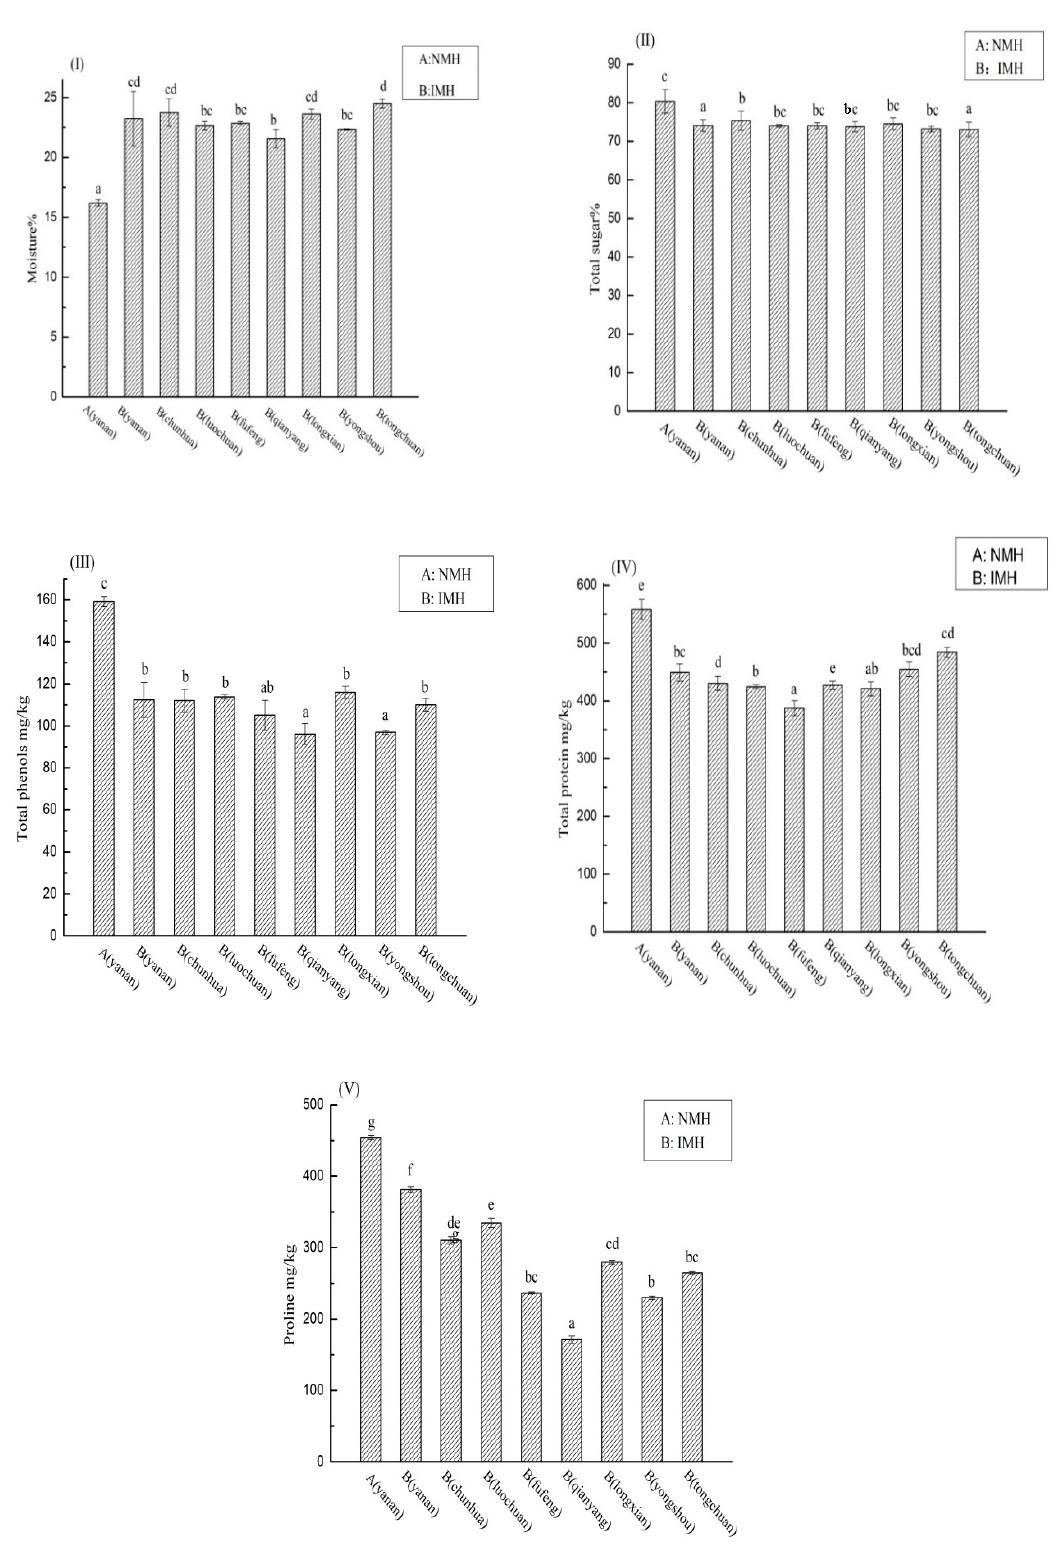
Figure 2. Significant physicochemical parameters of natural mature acacia honey (NMH) and immature acacia honey (IMH). Different lower case letters correspond to significant differences at p < 0.05. (I) represents moisture; (II) represents total sugar content; (III) represents total phenols content; (IV) represents total protein content; (V) represents proline content.